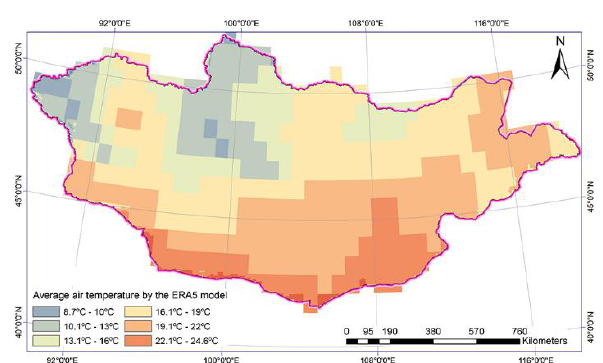
Figure 7. Average air temperature of the ERA5 model (between from 1982 to 2019).